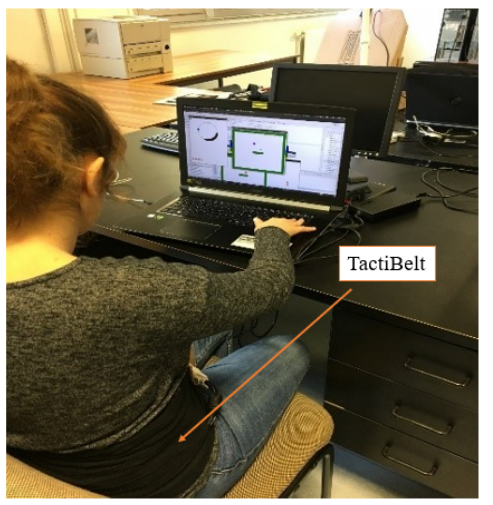
Figure 16. Navigation of a VIP in a simulated environment using the TactiBelt.